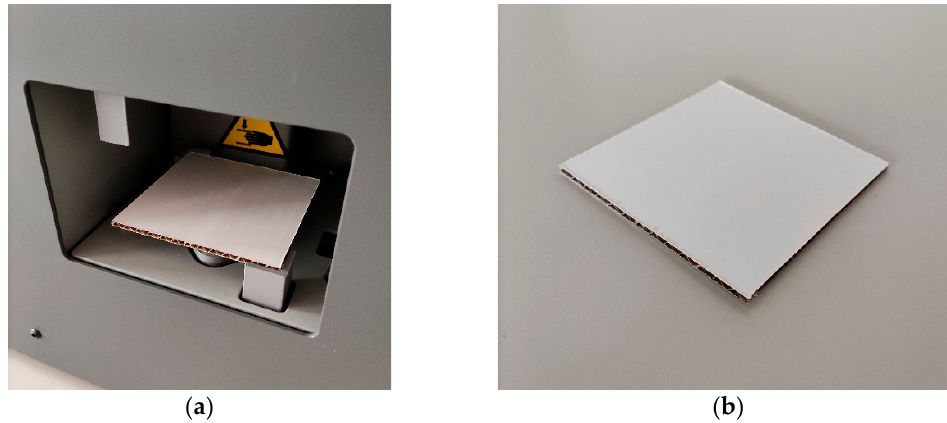
Figure 2. Shear stiffness test: ( a ) the testing socket and ( b ) the corrugated board sample.